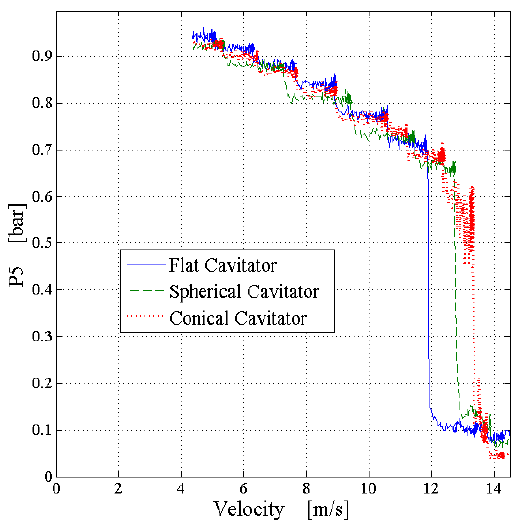
Figure 7. The wall pressure in P5 vs. the velocity in this section for the three cavitators 1